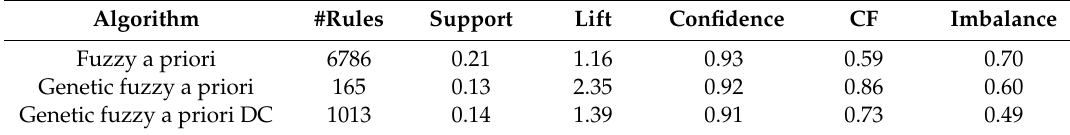
Table 3. Average results obtained by the three fuzzy